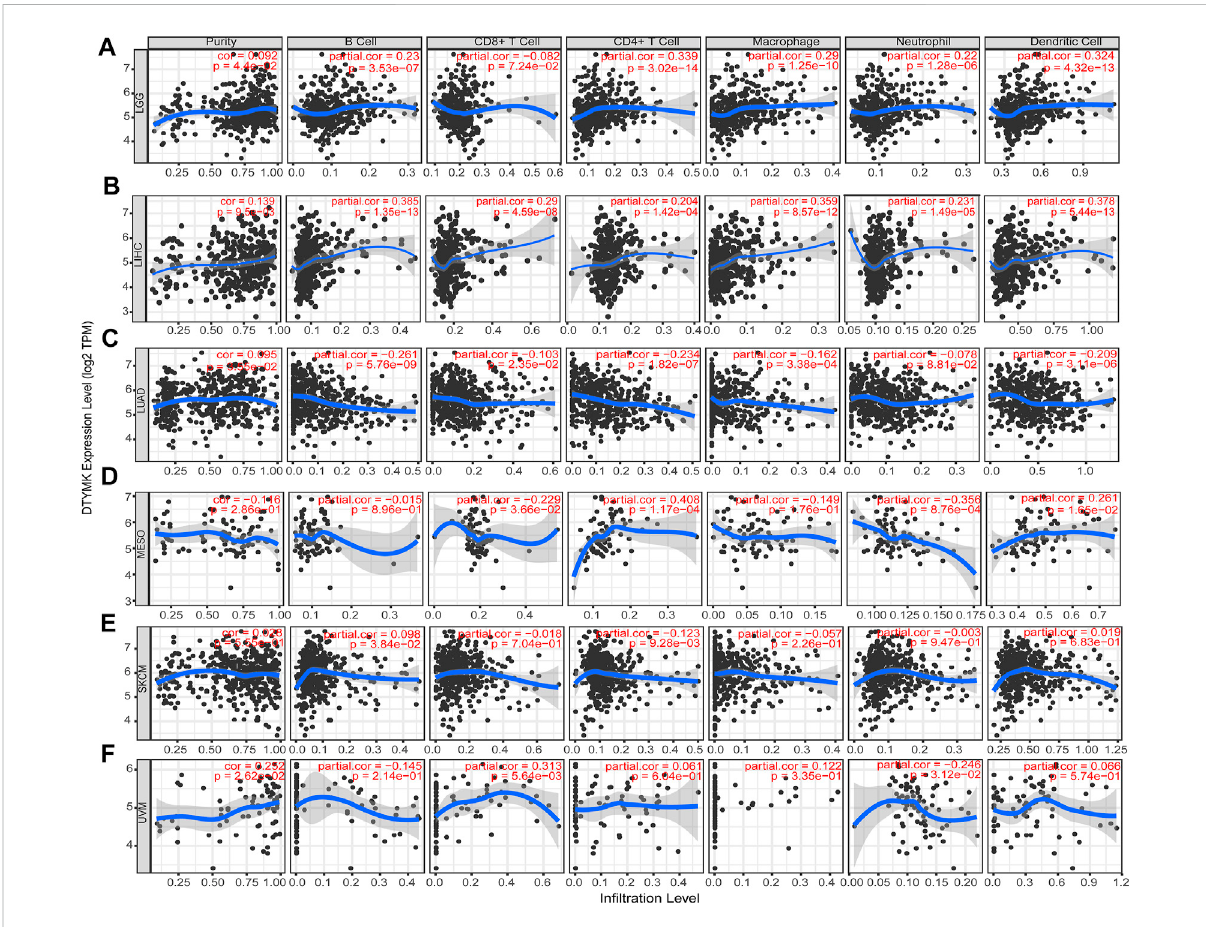
FIGURE 12 The relationship between DTYMK expression and immune in fi ltration levels. DTYMK expression was correlated with tumor-in fi ltrating immune cell levels in LGG (A) , LIHC (B) , LUAD (C) , MESO (D) , SKCM (E) , and UVM (F)